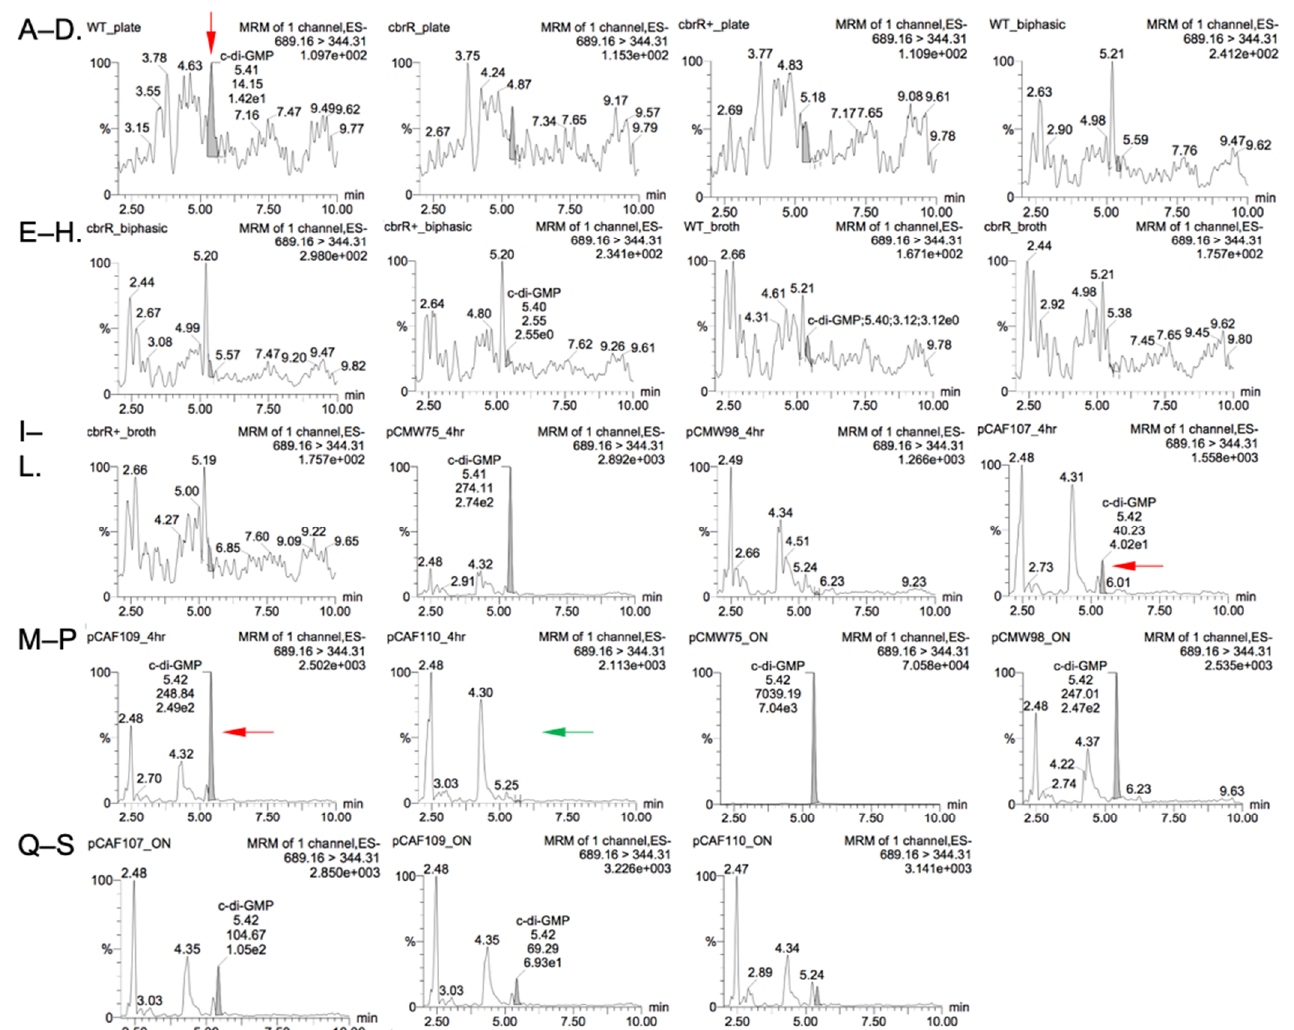
Figure 11. LC-MS/MS shows low level amounts of c-di-GMP produced by C. jejuni CbrR. Chro- matograms generated by LC-MS/MS show peak intensity of c-di-GMP for samples of C. jejuni cells: ( A ) WT Plate, ( B ) cbrR − Plate, ( C ) cbrR + Plate, ( D ) WT Biphasic, ( E ) cbrR − Biphasic, ( F ) cbrR + Biphasic, ( G ) WT Broth, ( H ) cbrR − Broth, ( I ) cbrR + Broth; and E. coli cells: ( J ) pCMW75 4 Hr, ( K ) pCMW98 4 Hr, ( L ) pCAF107 4 Hr, ( M ) pCAF109 4 Hr, ( N ) pCAF110 4 Hr, ( O ) pCMW75 O/N, ( P ) pCMW98 O/N, ( Q ) pCAF107 O/N, ( R ) pCAF109 O/N, ( S ) pCAF110 O/N. WT C. jejuni and recombinant E. coli (WT CbrR